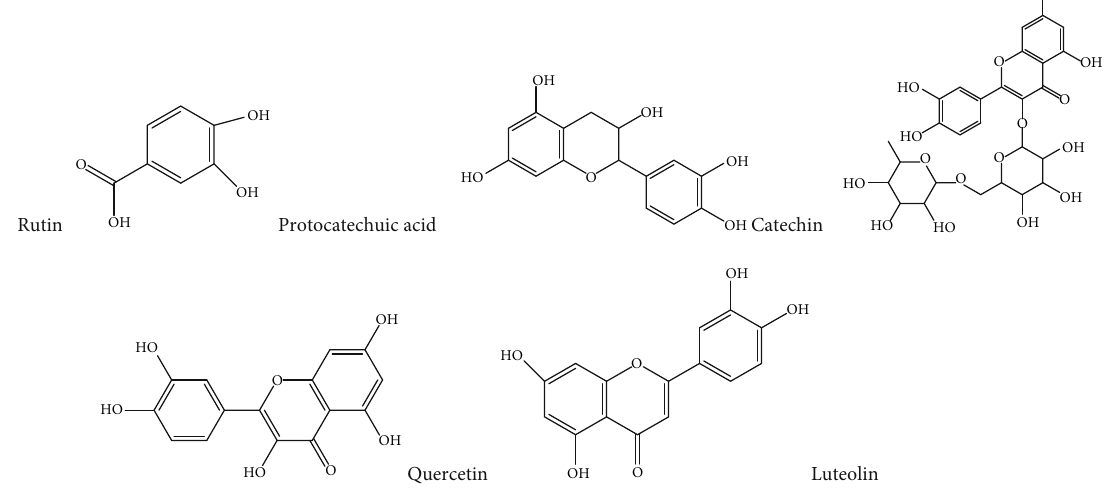
Figure 1: Structure diagram of each